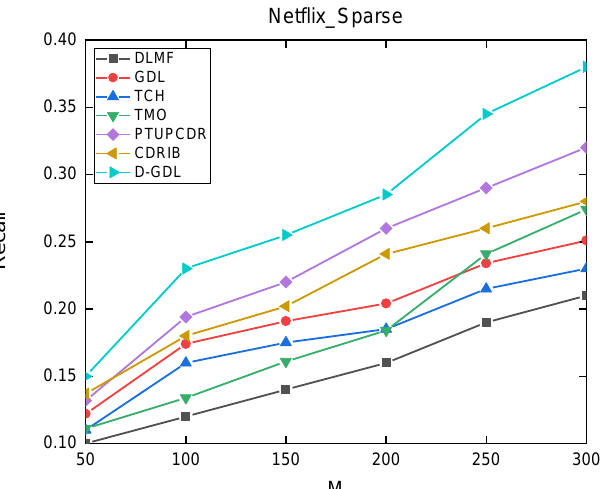
Figure A2. Performance of D-GDL against the comparative approaches based on Recall vs. M for CiteULike-t dataset in the sparse setting.